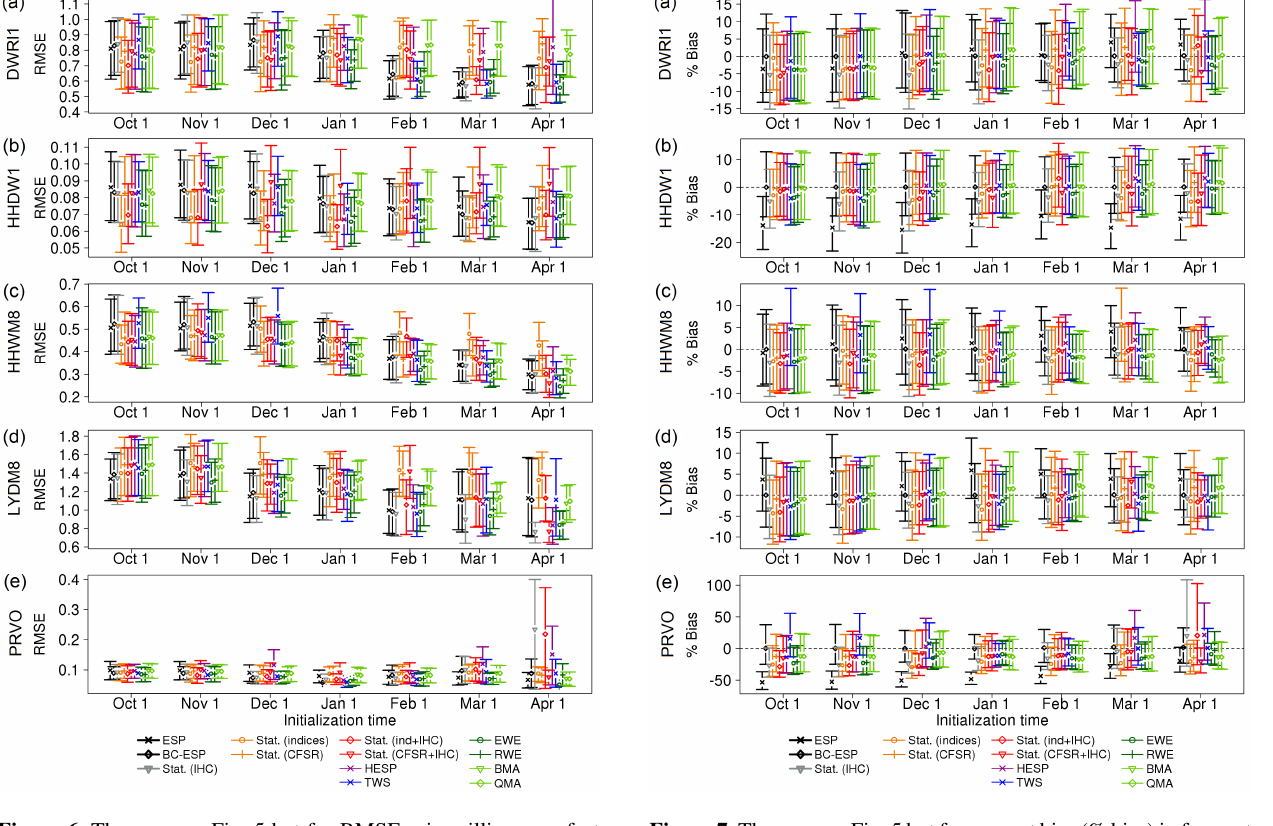
Figure 6. The same as Fig. 5 but for RMSE – in million acre feet (MAF) – of ensemble forecast medians versus observations. See text for further details.